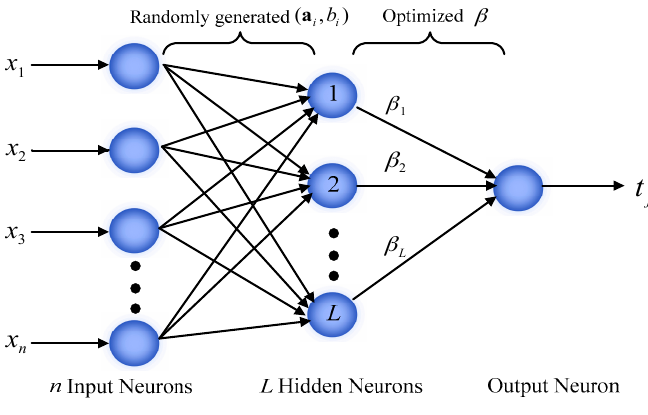
Figure 1. Basic architecture of ELM.